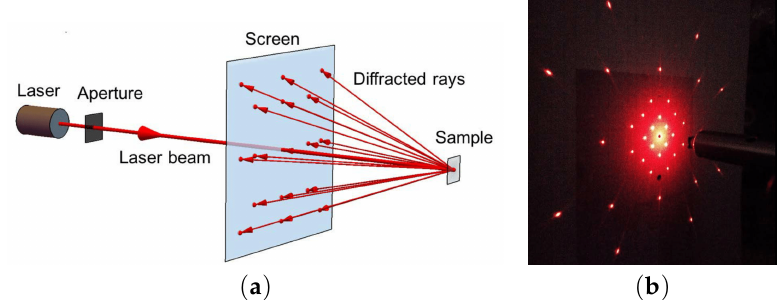
Figure 26. ( a ) principle scheme of the laser beam illuminating the metasurface for obtaining a diffraction pattern on the other side of the screen; ( b ) picture of this diffraction pattern obtained with a laser of wavelength λ = 632.8nm. The other parameters are available in [18], reprinted with permission from [18], the Optical Society (OSA).